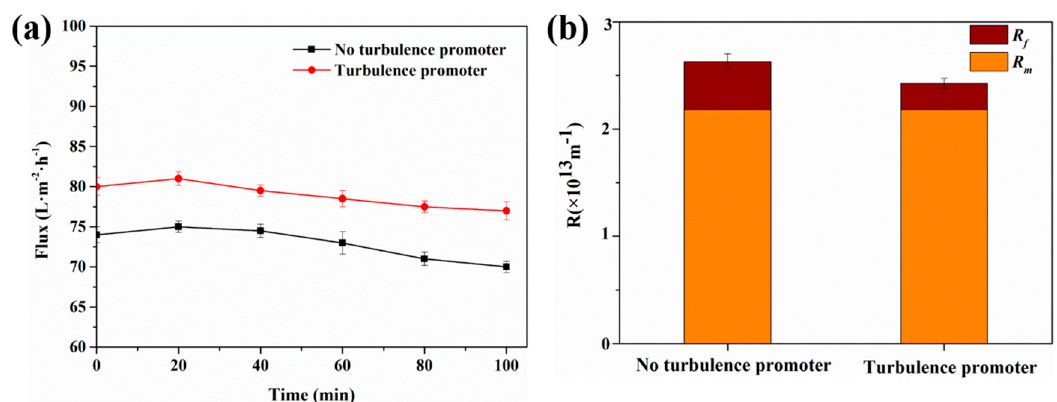
Figure 11. ( a ) Variations of flux with time and ( b ) effect of the turbulence promoter on membrane fouling resistance (SSTS: 500 ppm HA, pH = 4; TMP = 0.5 MPa).